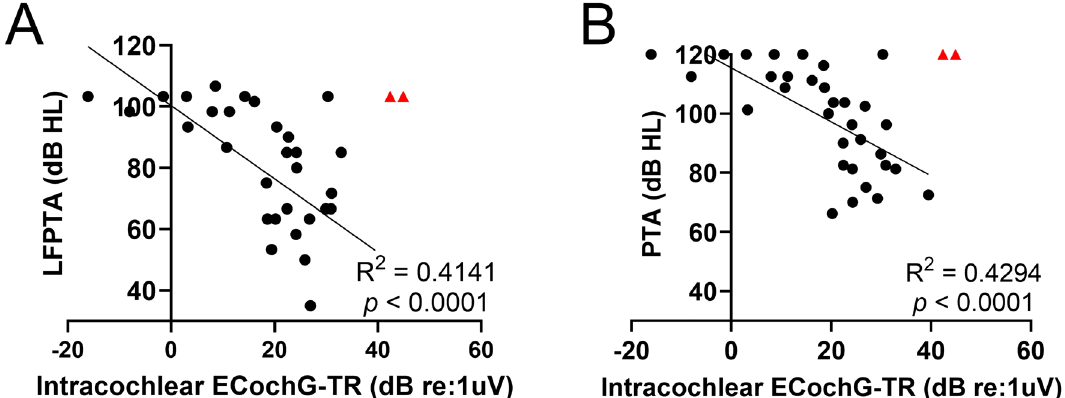
Figure 2. Univariate regression shows a moderate linear correlation between audiogram and intracochlear electrocochleography total response (ECochG-TR). Behavioral audiogram thresholds are likely a cumulative measure of both peripheral (i.e., auditory nerve and hair cells) and central auditory functioning; in contrast, intracochlear ECochG can provide direct and separate measures of acoustically evoked responses from the auditory nerve and hair cells. ( A ) Low-frequency pure tone average (LFPTA; 125, 250, 500 Hz) as a function of intracochlear ECochG-TR, and ( B ) Pure tone average (PTA; 500, 1000, 2000, 4000 Hz) as a function of intracochlear ECochG-TR. Red triangles denote outliers that were removed for univariate linear regression as these patients had auditory neuropathy spectrum disorder with large cochlear microphonic, contributing significantly to the ECochG-TR, and no neural response.